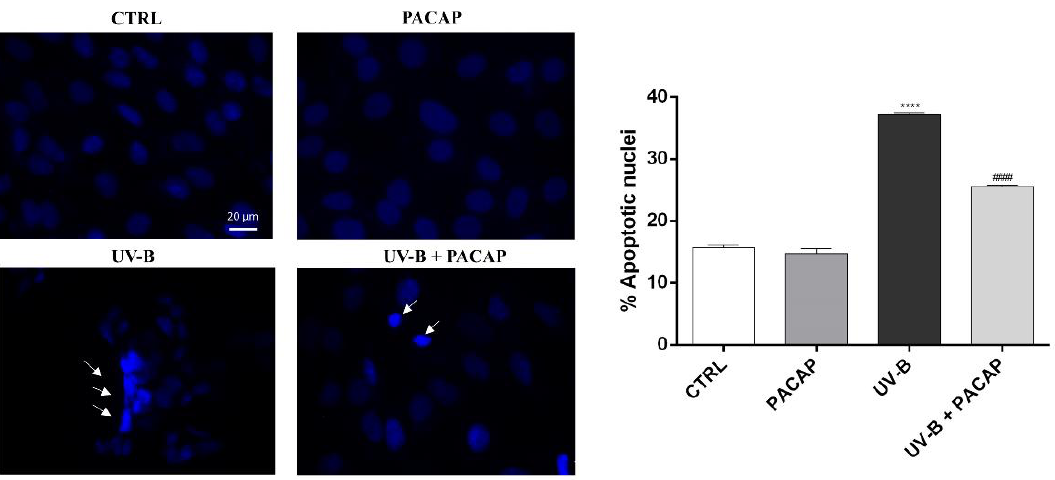
Figure 3. Assessment of cell death using Hoechst 33342 staining. Scale bar: 20 μm . **** p < 0.0001 vs. CTRL; #### p < 0.0001 vs. UV-B.